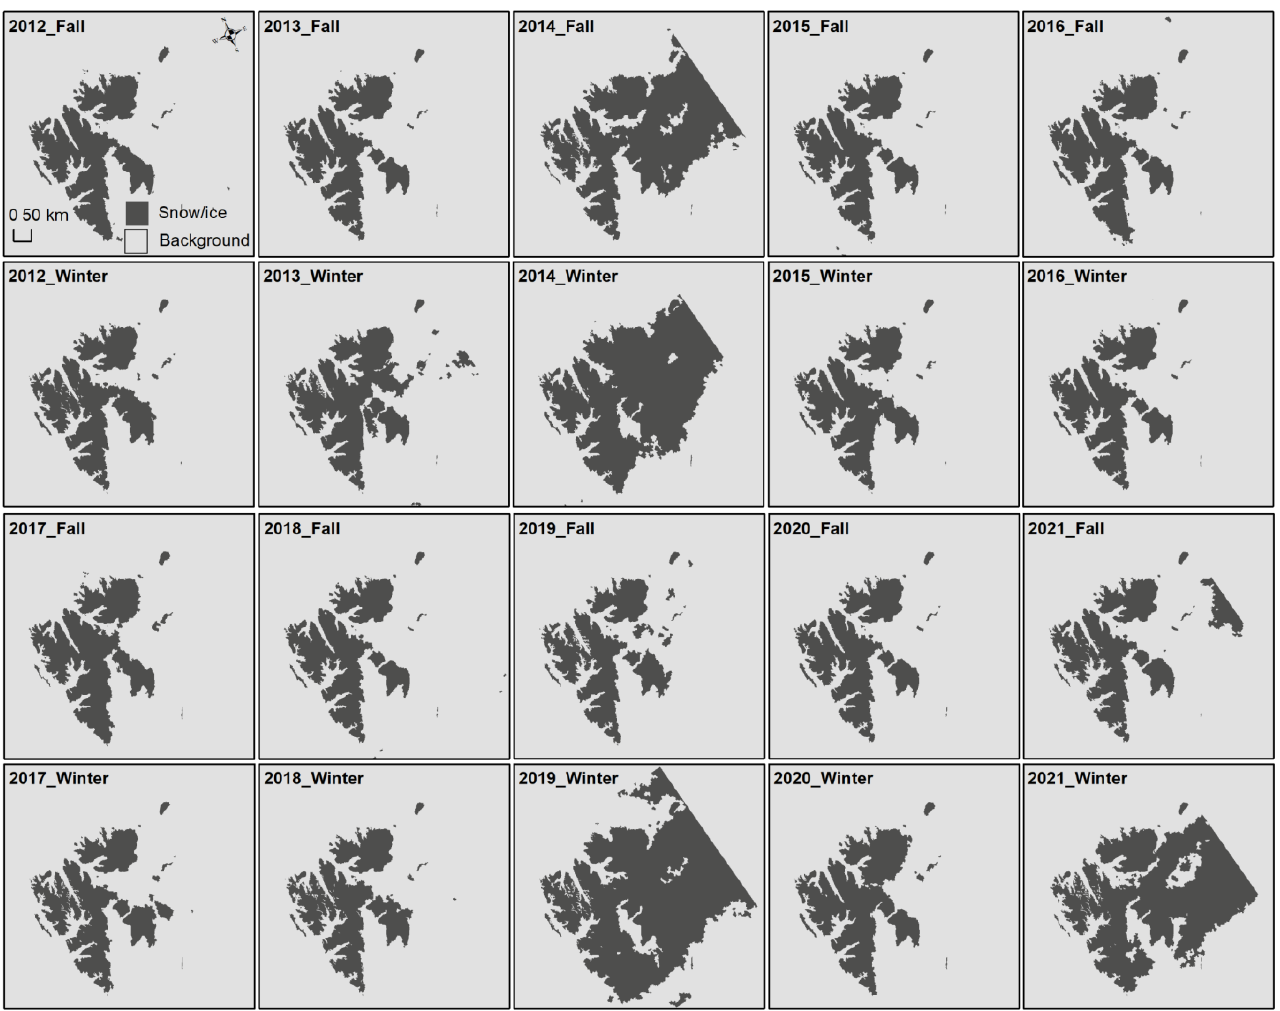
Figure 8. Snow/ice cover maps from 2012 to 2021.